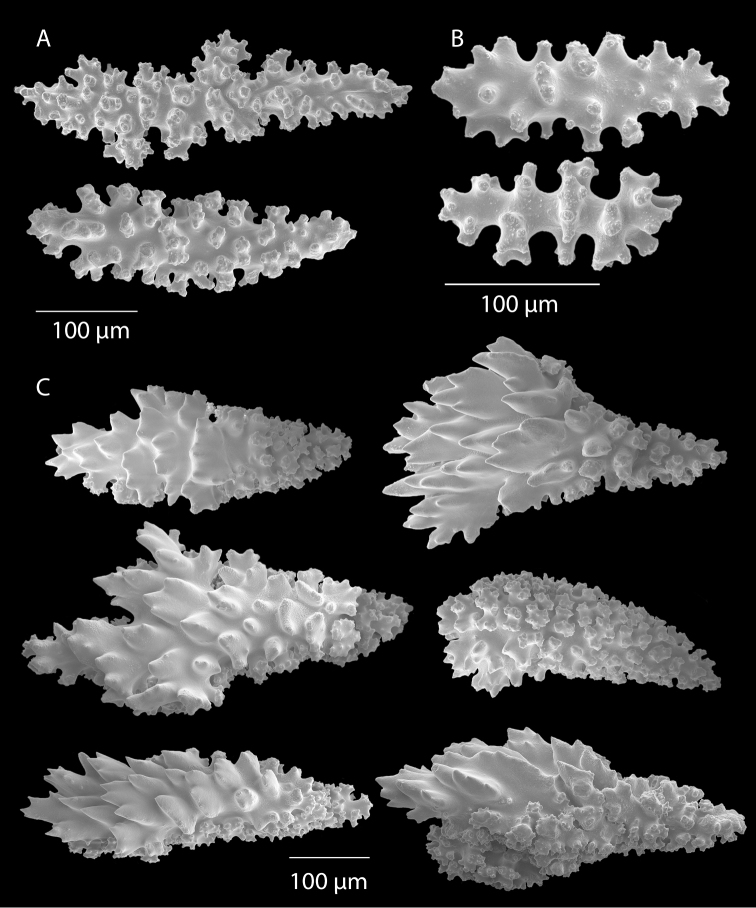
Muriceacalifornica, SBMNH 265938, SEM image. A, B Axial sheath sclerites A Very jagged spindles B Moderately “toothed” spindles C Calycular/coenenchymal torch-type spindles. Compare/contrast with those shown in Breedy and Guzmán 2016 (fig. 21).